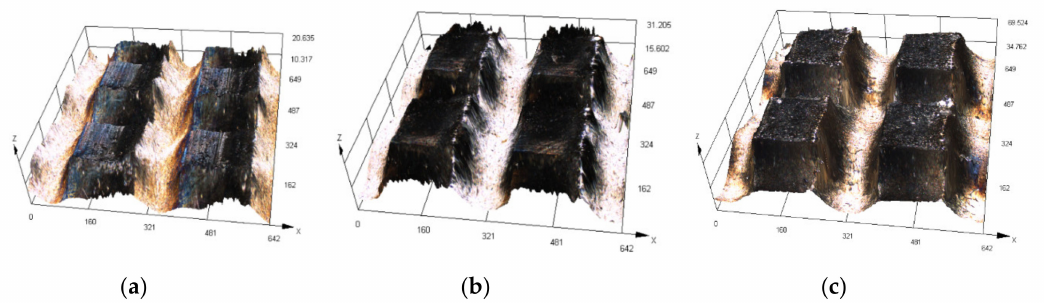
Figure 11. Microtexture morphologies under di ff erent laser powers at 1.6 mm / s scanning speed: ( a ) 60 W microtexture; ( b ) 70 W microtexture; ( c ) 80 W microtexture.